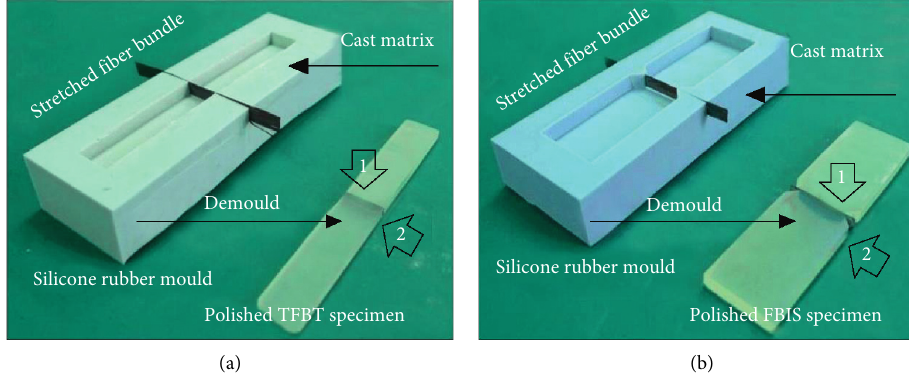
Figure 11: Preparation of TFBT and FBIS test pieces for fiber bundle test [106].